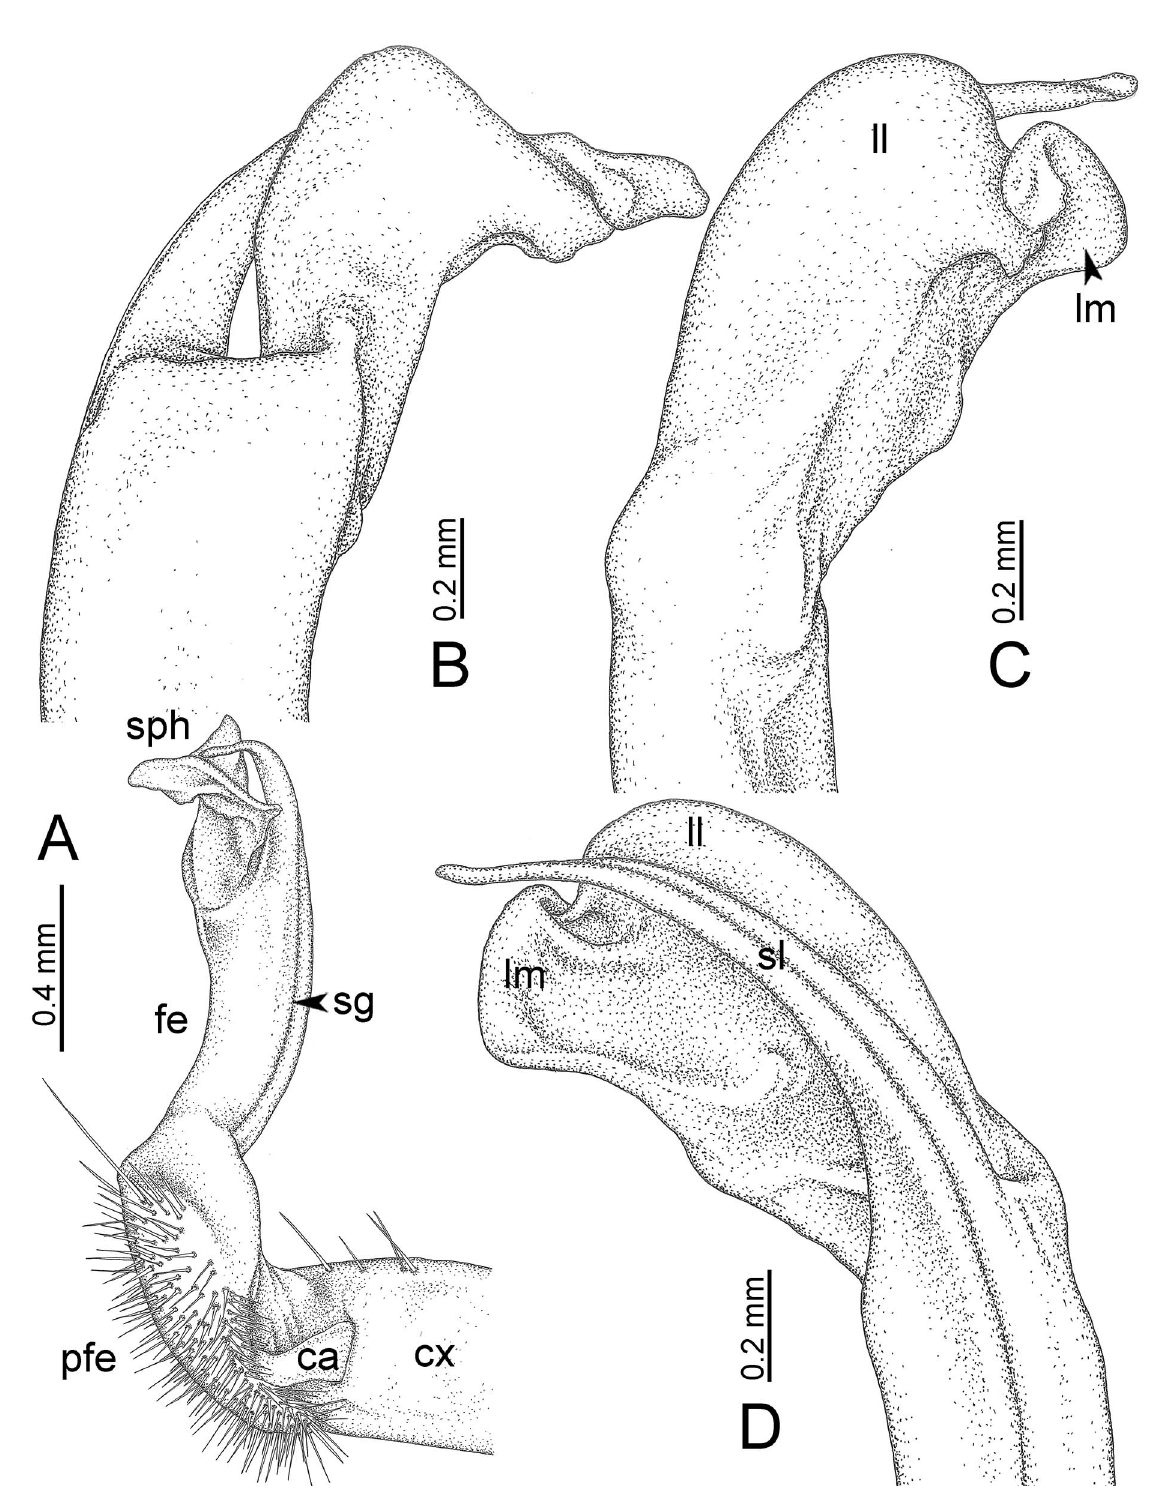
Fig. 22. Gigaxytes suratensis Srisonchai, Enghoff & Panha gen. et sp. nov . , ♂ paratype – right gonopod. A . Mesal view. B . Lateral view. C . Ventral view. D . Dorsal